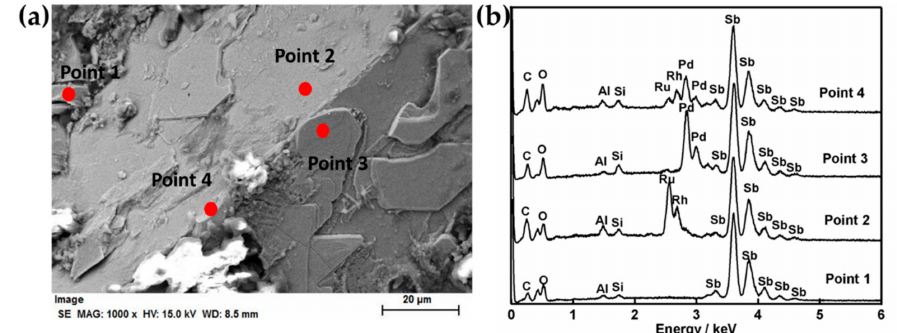
Figure 3. ( a ) FE-SEM image and ( b ) EDS spectra of point analysis on the recovered Sb metal phase- Figure 3. ( a )FE-SEMimageand( b )EDSspectraofpointanalysisontherecoveredSbmetalphase-separated separated from the heat-treated product in batch 1. from the heat-treated product in batch